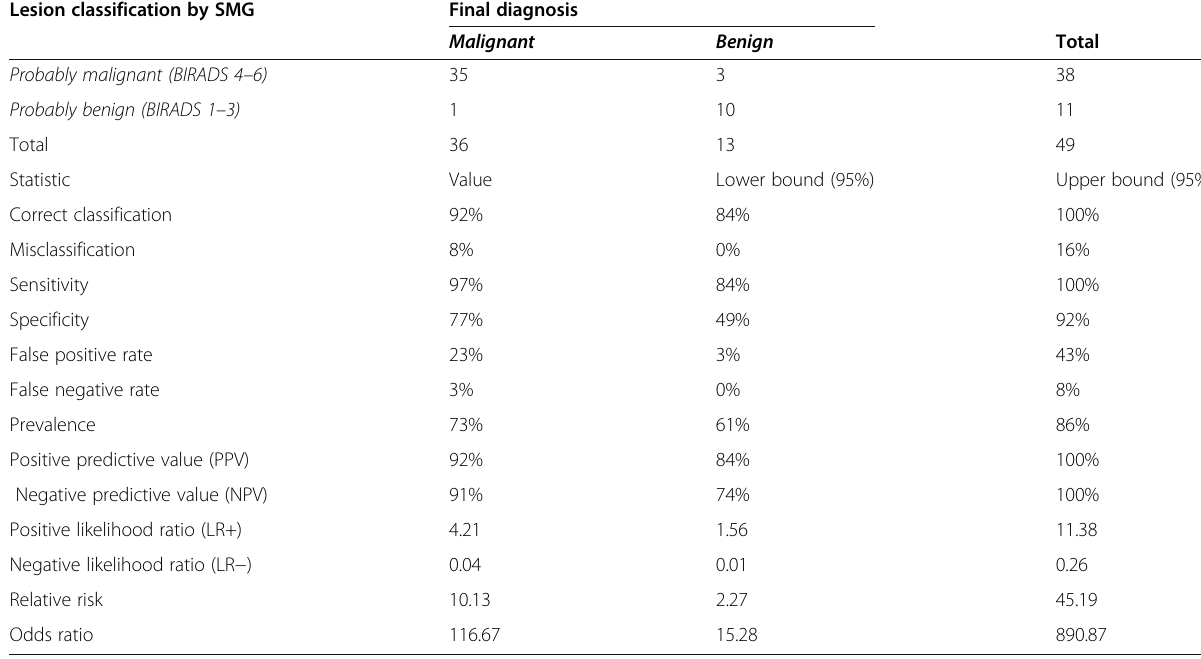
Table 8 Diagnostic accuracy of CESM tested in patients with ACR grade A/B versus the result of biopsy or follow-up as the gold standard for lesion classification